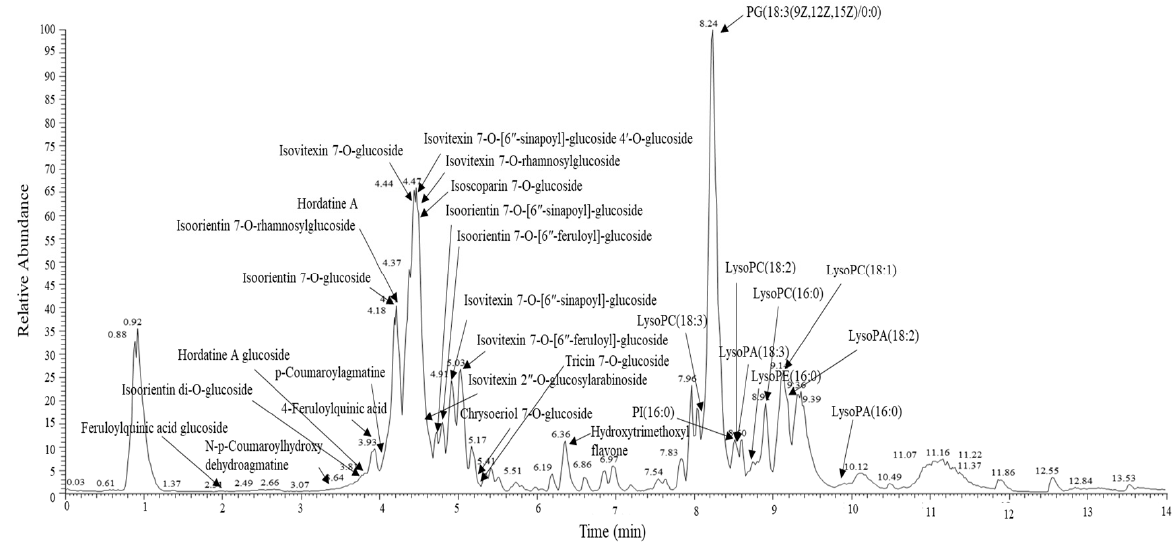
Figure 1. The UHPLC-LTQ-Orbitrap-MS/MS chromatogram of the BSE. UHPLC-LTQ-Orbitrap-MS/MS, ultrahigh- performance liquid chromatography linear trap quadrupole orbitrap tandem mass spectrometry; BSE, barley sprouts extract powder.